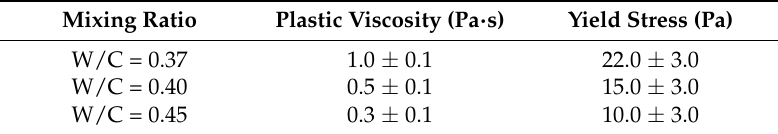
Table 3. Measured rheological ranges for tested mixing ratios.